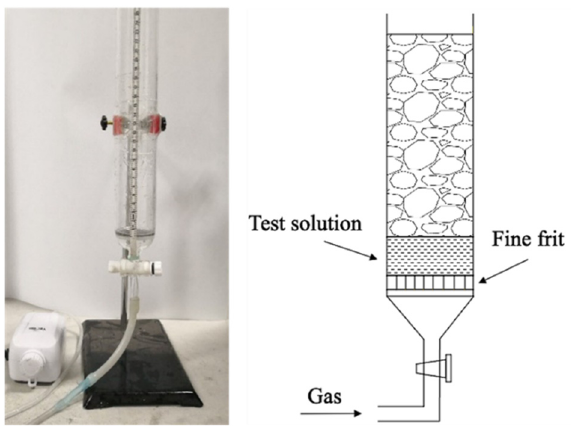
Figure 2. The illustration of the glass tube for foam properties analysis.